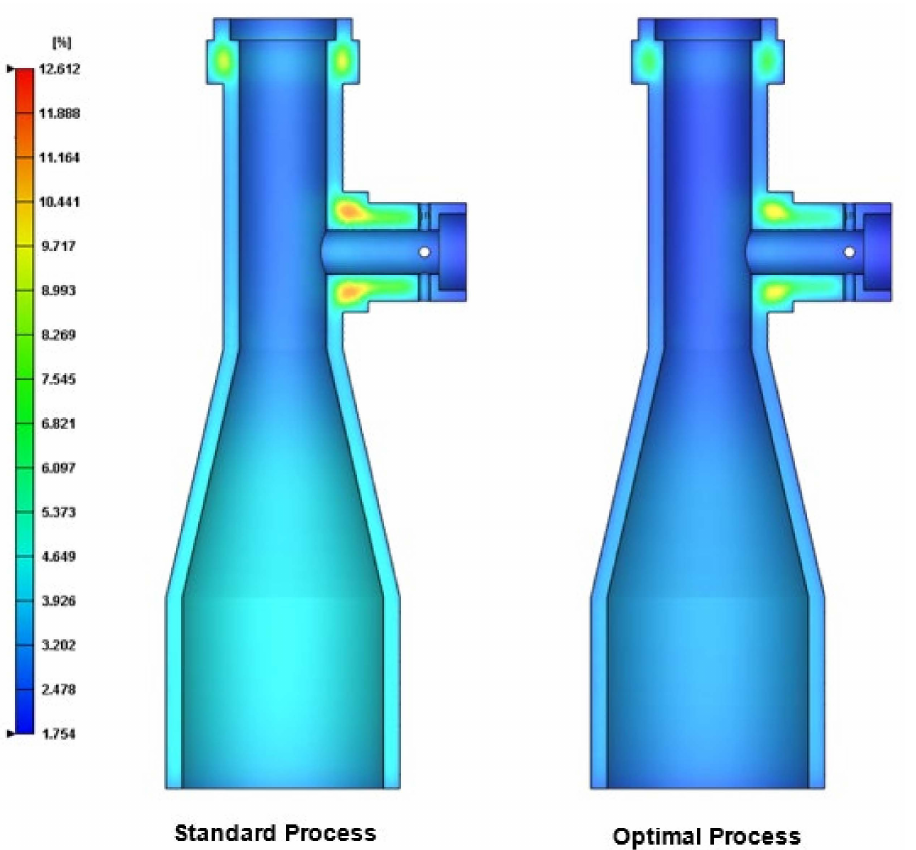
Figure 11. Cross-sectional shrinkage of final part processed using standard conditions ( left ) and optimal conditions ( right ). (Volume shrinkage: